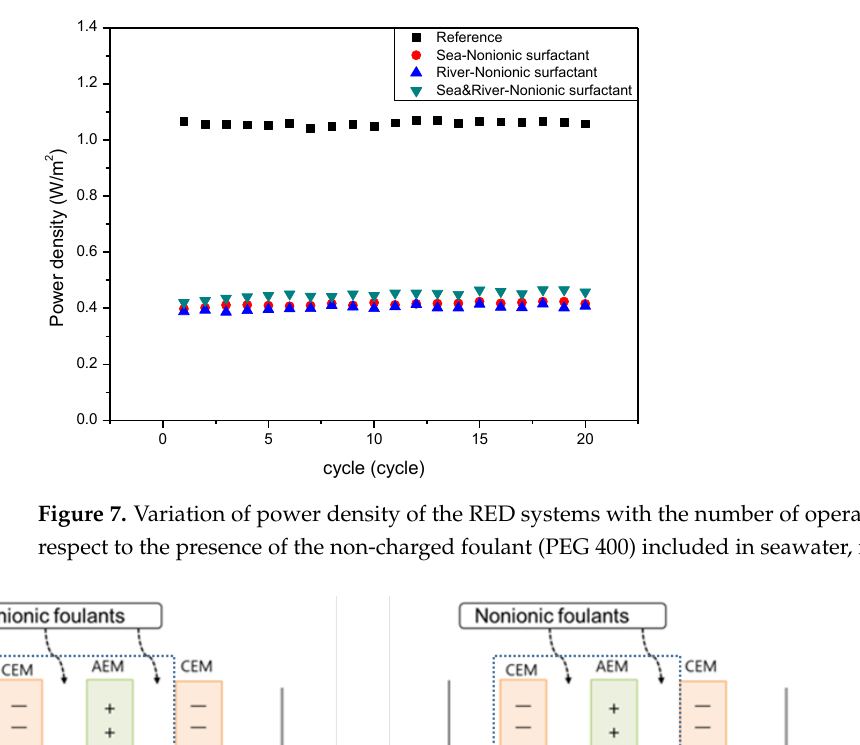
Figure 8. Illustration of showing ( a ) the hypothesis and ( b ) the experimental result of the RED system with only one cell pair (the part within the dashed square) supplying seawater and river containing non-charged foulants.